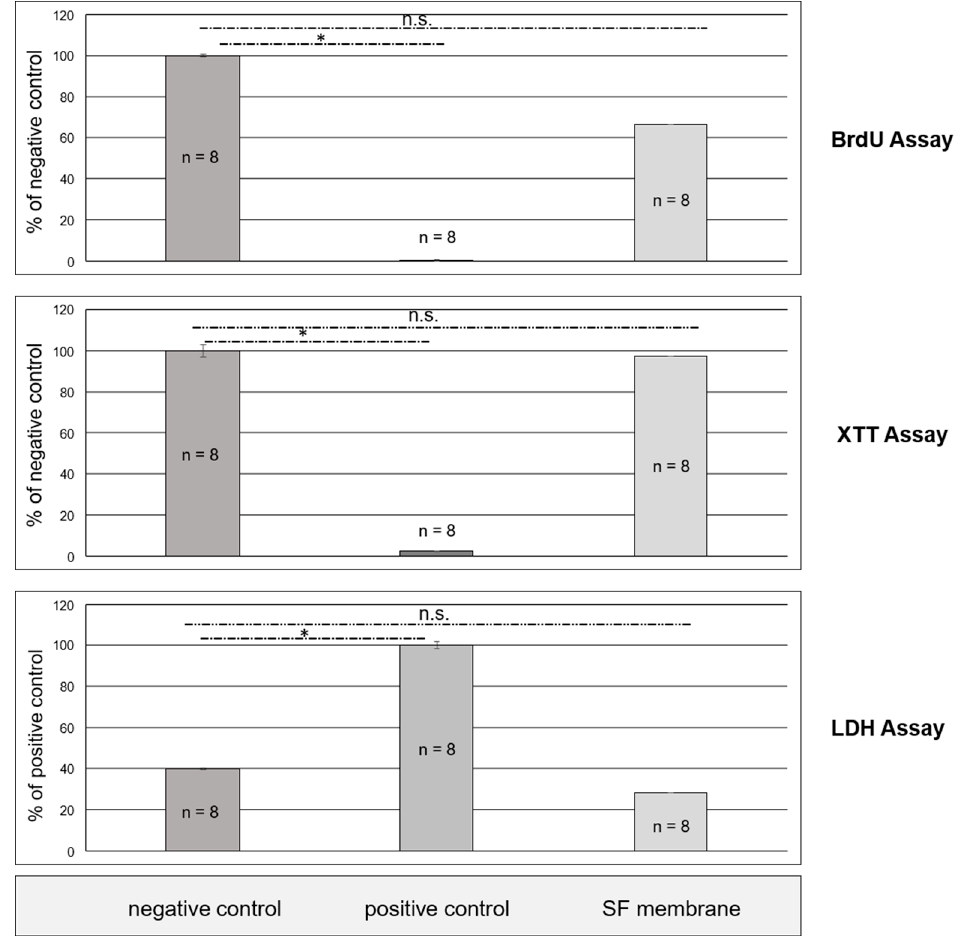
Figure 9. Results of indirect cytotoxicity tests on SF membrane with FA and CaCl 2 , following the ISO 10993-5, indicating statistical significance ( p ≤ 0.05 (*); non significance (n.s.)).